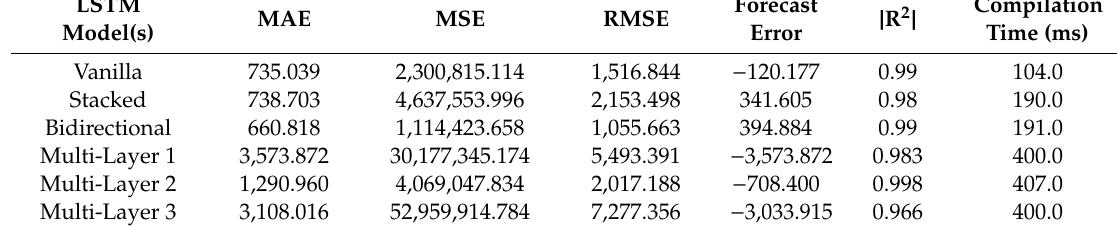
Table 12. Average performance analysis of LSTM models to forecast total death of the “World”.